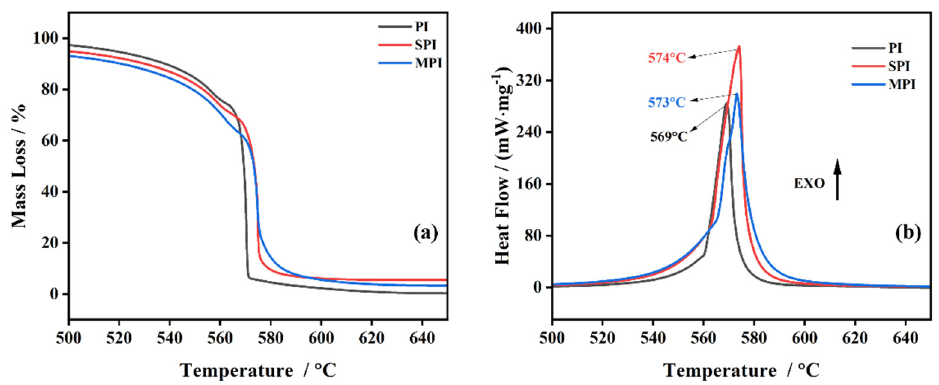
Figure 5. TG ( a ) and DSC ( b ) curves of the three substances under an O 2 atmosphere. The peak temperatures of the DSC curves of PI, SPI, and MPI are 569 °C, 573 °C, and 574 °C, respectively. The results imply that the additions of SiO 2 and Mg(OH) 2 have little effect on the first decomposition of PI under an O 2 atmosphere, whereas the peak temper- atures of the second step of SPI and MPI increased by 5 °C compared with that of PI.